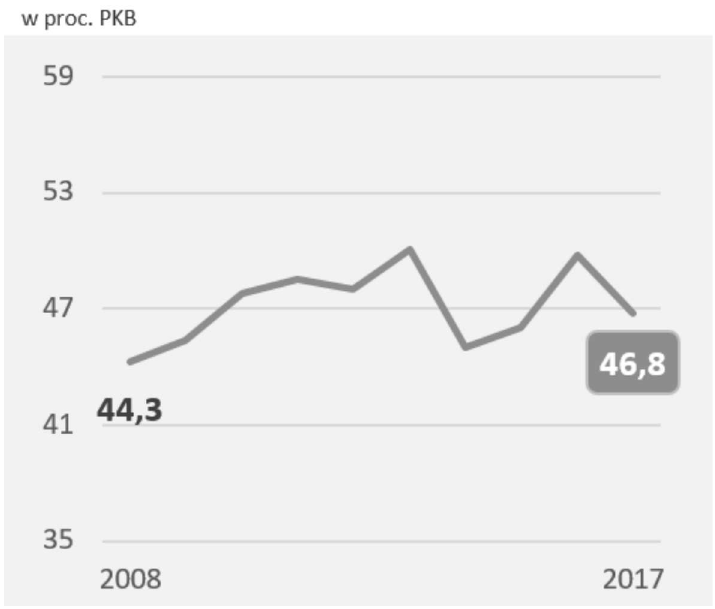
Figure 3. Public debt of Poland in relation to GDP